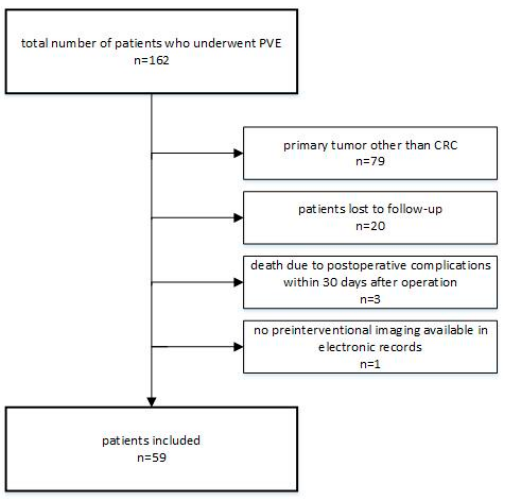
Figure 1. Flow chart of study inclusion/exclusion .